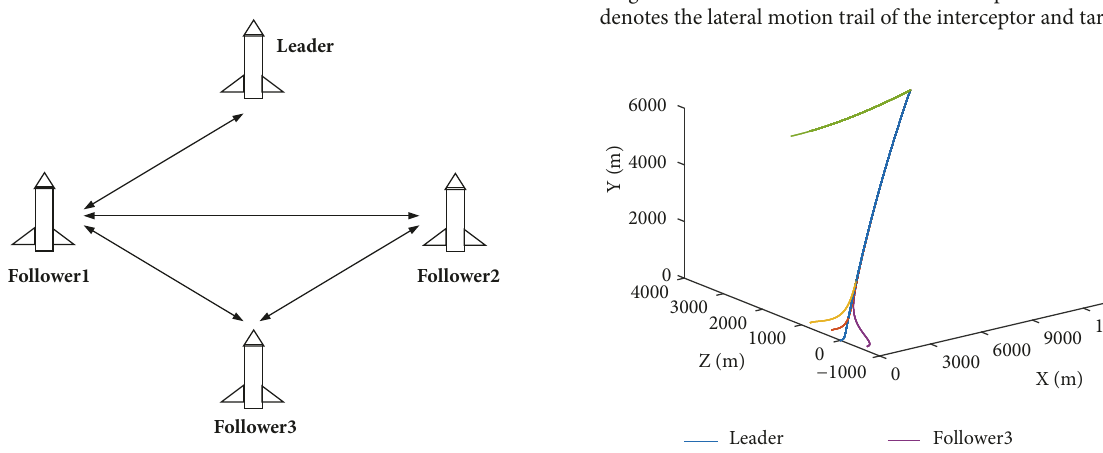
Figure 2: Local communication topology structure of the intercep- tor “leader” and “follower”.